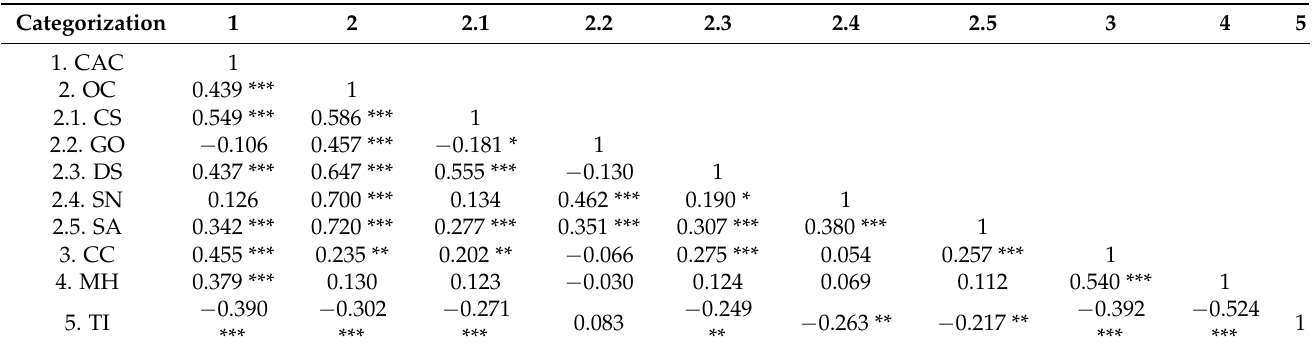
Table 3. Correlation analysis of cross-cultural adjustment competency, occupational competency, coping competency, mental health, and turnover intention.